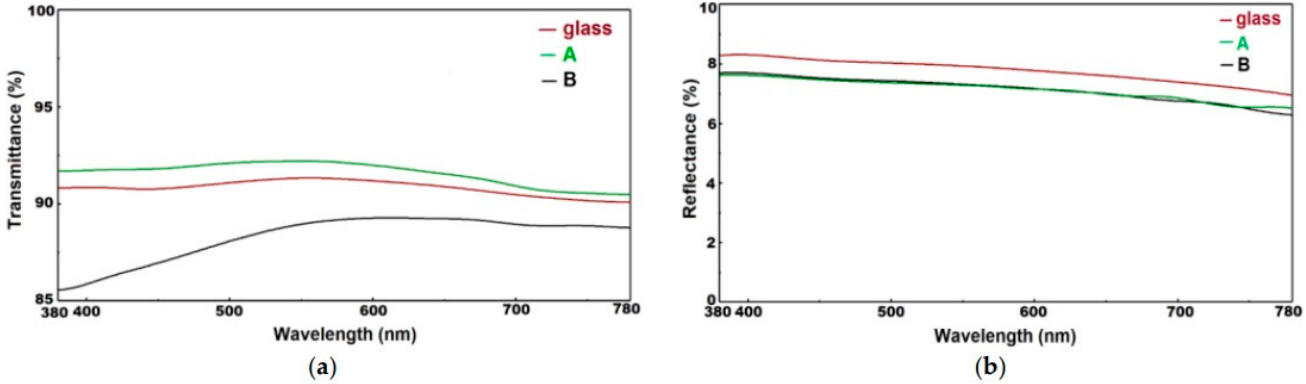
Figure 7. ( a ) Transmittance and ( b ) diffuse reflectance spectra of hybrid films (glass substrates coated with silica material (sample A) and with silver-based silica material (sample